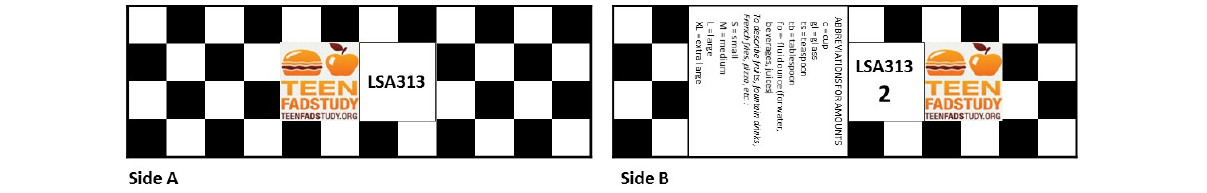
Figure 1. Fiducial marker with two sides that show the identification (ID) number of the participant and the study logo (Sides A and B), and commonly used portion size measurements (Side B).